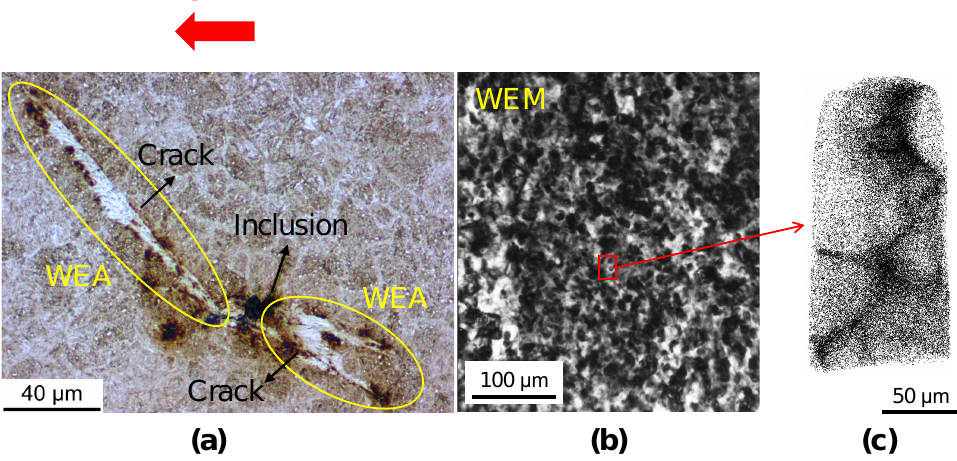
Figure 3. Formation of WEAs. ( a ) Optical image of a pair of WEAs initiated from an inclusion. The image was adapted from ref. [8]. ( b ) Unpublished TEM image of the microstructure inside WEM. ( c ) APT result of carbon distribution in a dislocation cell in WEM. The image was adapted from ref.